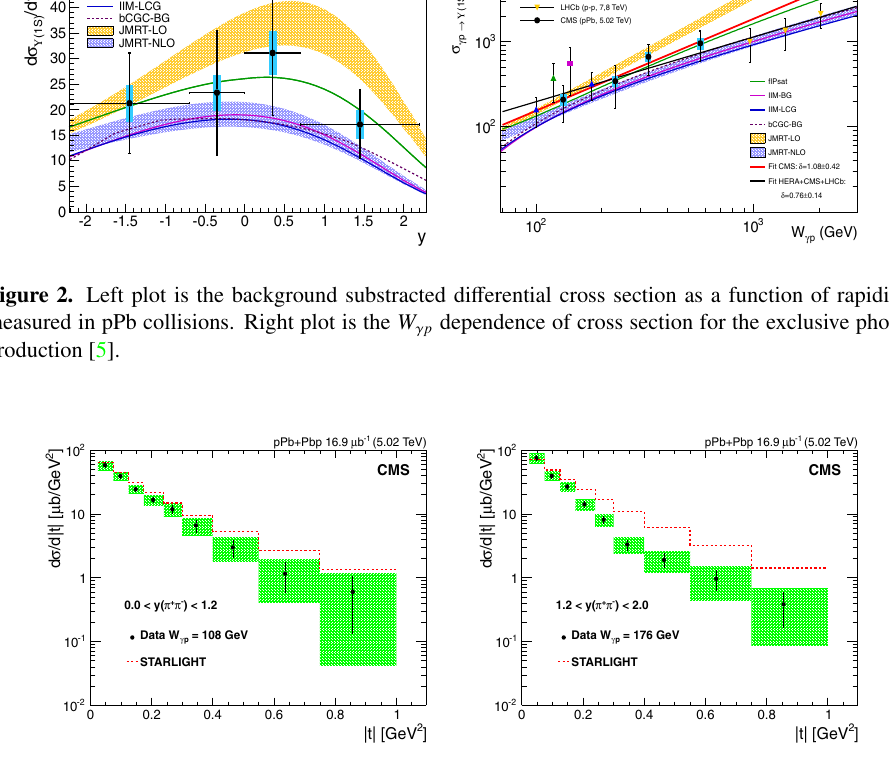
Figure 3. Di ff erential cross section (d σ / d t ) is measured for ρ 0 as a function of rapidity bin [4]. The dashed dotted line indicates the predictions from starlight . The error bars show the statistical uncer- tainty, and the shaded green areas represent the systematic uncertainties of that